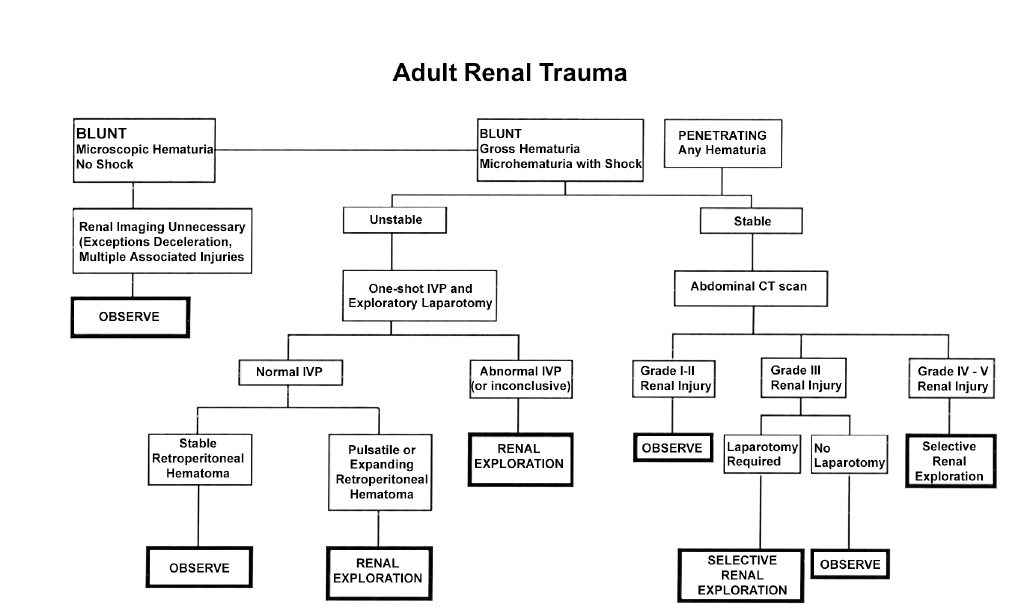
Figure 1 - Algorithm for treating patients with renal trauma. (Reprinted with permission from: Meng MV, Brandes SB, McAninch JW. Renal trauma: indications and techniques for surgical exploration. World J Urol. 1999; 17: